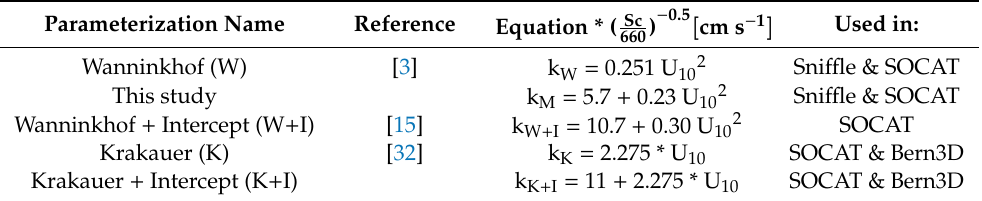
Table 2. List of gas transfer velocities parameterization (with equation, units, and references) used in Sni ffl e, the surface ocean observation–based method (SOCAT), and Bern3D